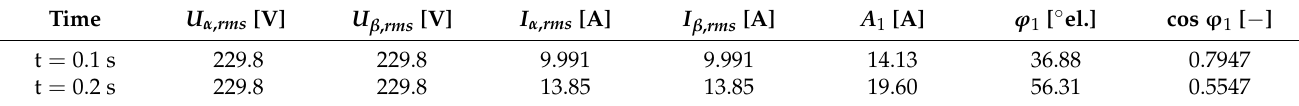
Table 10. Simulation results before and after the change (at steady states).